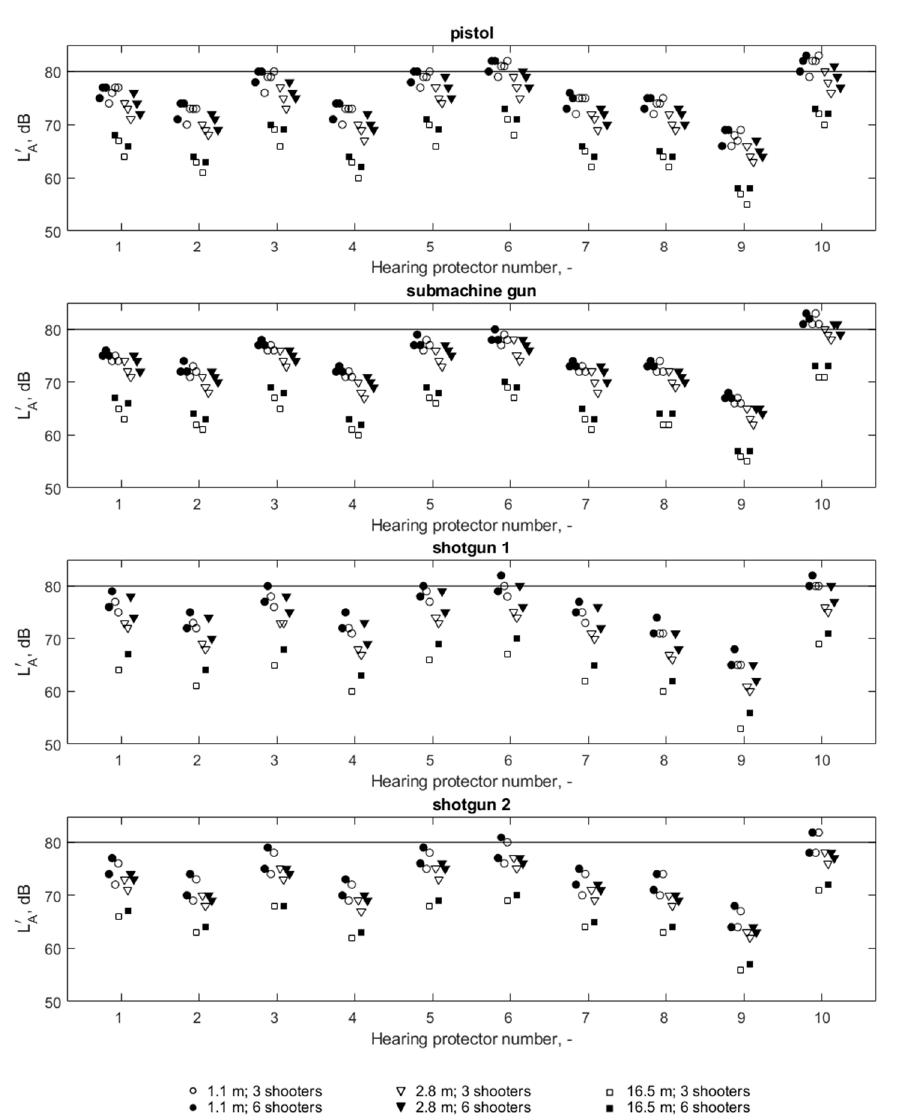
(cid:48) Figure9. L values(underhearingprotectors)forfourweapon / ammunitioncombinations. Ahorizontal A Figure 9. L (cid:2885)(cid:4593) values (under hearing protectors) for four weapon/ammunition combinations. A solid line indicates a criterion value of 80 horizontal solid line indicates a criterion value of 80 dB. Table 2. The highest values of noise parameters under hearing protectors determined from all the measuring situations included in the study (53 shooting cycles).